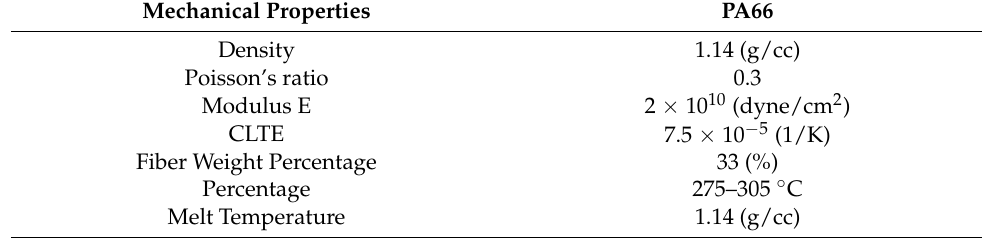
Table 1. PA66 Material Characteristics. Mechanical Properties